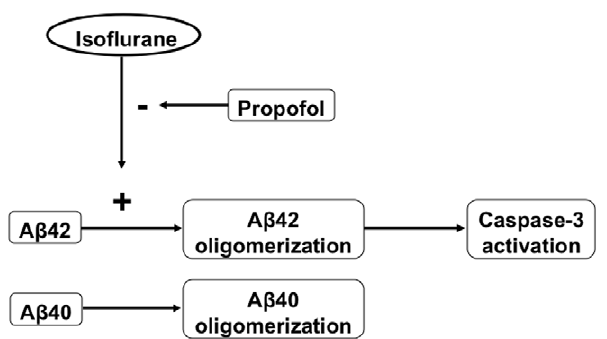
Figure 5. Hypothetical pathway by which propofol attenuates the isoflurane-induced caspase-3 activation. Isoflurane can induce oligomerization of A b 42 but not A b 40. The A b 42 oligomer then causes caspase-3 activation. Propofol inhibits the isoflurane’s effects on promoting A b 42 oligomerization, leading to the attenuation of the isoflurane-induced caspase-3 activation.